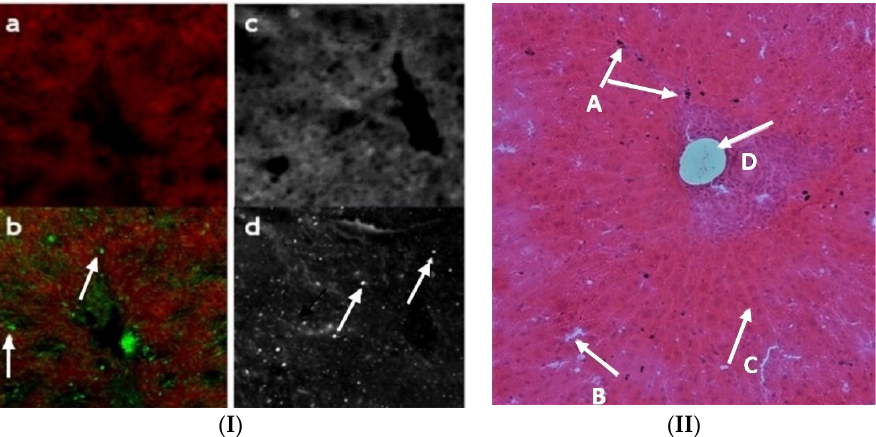
Figure 6. Cellular distribution of 99m Tc Q9P35GC micelles. ( I ) Excised liver tissue images captured after 1 h after FITC Q9P35GC/India ink administration; ( a , b ) confocal images, green spots of FITC Q9P35GC in hepatocytes and black spot of India ink in Kupffer cells; ( c , d ) light microscope images, white spots of FITC Q9P35GC in hepatocytes and black spot of India ink in Kupffer cells, n = 3; ( II ) Biodistribution of India ink in the liver 1 h after the administration (as determined by light microscope image at 10 X, ( A ) Kupffer cells with India ink, ( B ) sinus spaces, ( C ) hepatocytes arranged in chords, ( D ) portal vein.